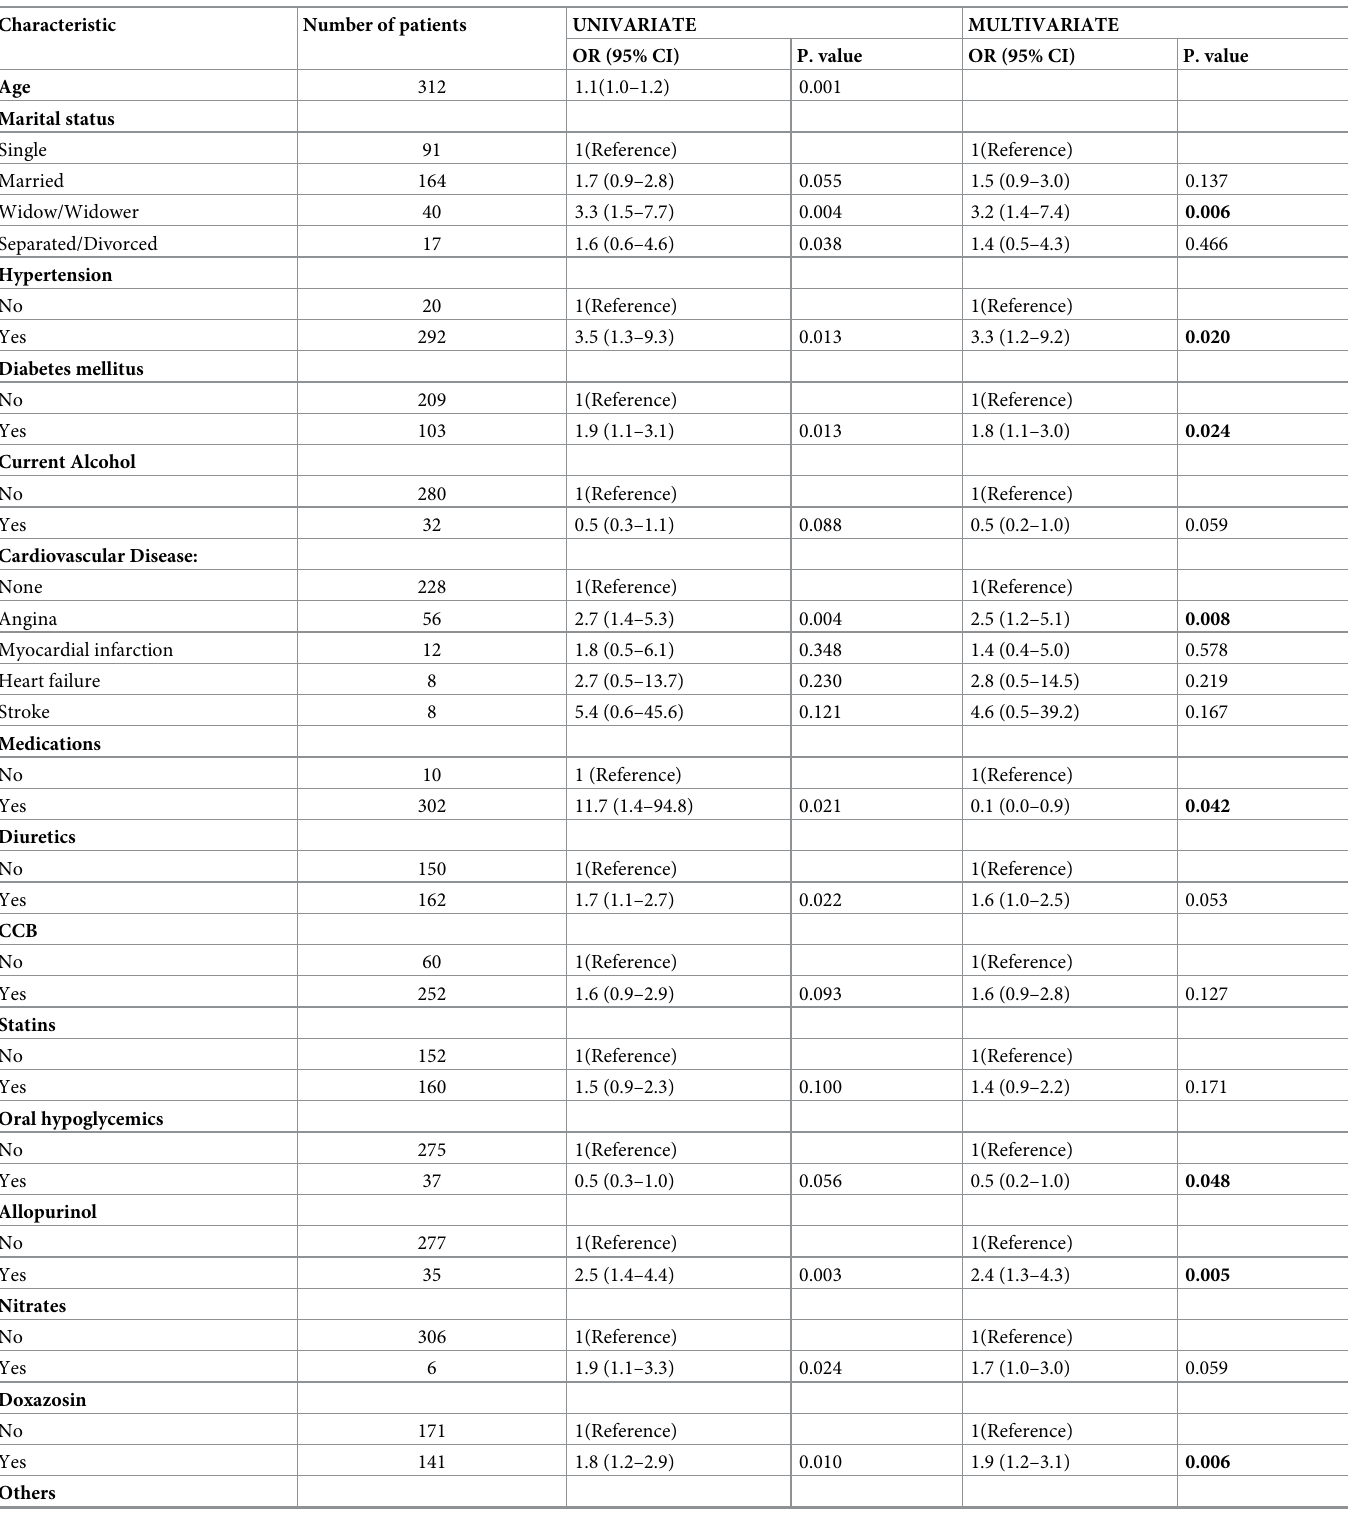
Table 3. Factors associated with advanced